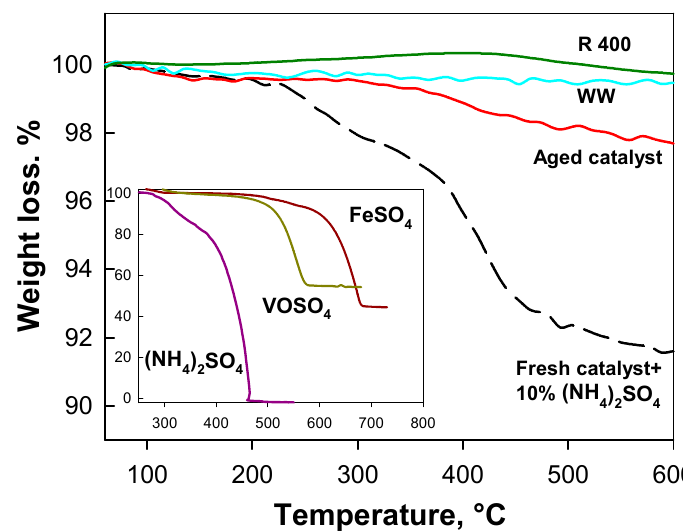
Figure 6. TG analysis (in N 2 ) of a fresh catalyst sample impregnated with 10 wt% (NH 4 ) 2 SO 4 , a reaction-aged catalyst sample, and the same catalyst after regeneration by either thermal treatment (R400) or water treatment (WW). The inset shows the TG profile recorded for the thermal decomposition of reference bulk sulfates.